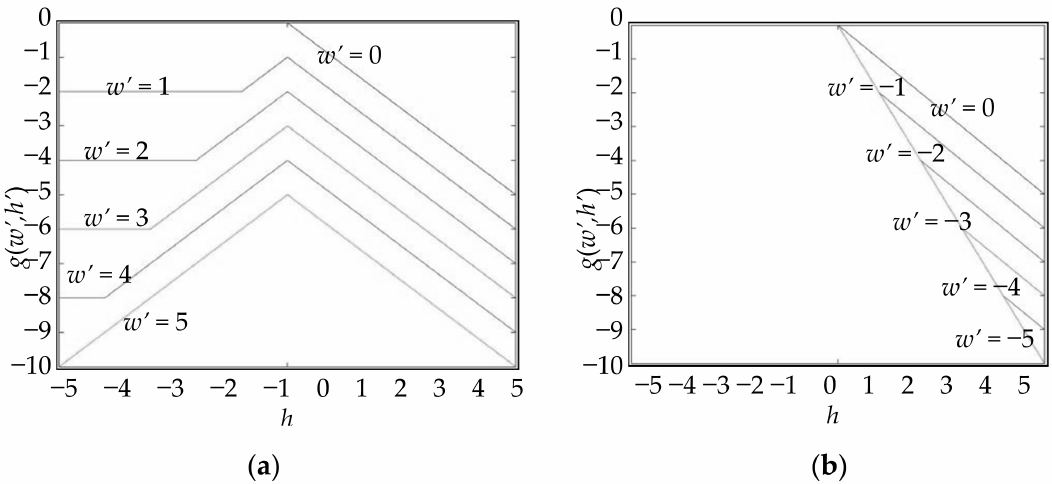
Figure 3. The curve g ( w (cid:48) , h (cid:48) ) at σ = ReLU: ( a ) w (cid:48) > 0; ( b ) w (cid:48) < 0. When the conditions ( σ = ReLU, h (cid:48) < 0.3, w (cid:48) < 0, and y label > 0) are met, the algorithm has the possibility of